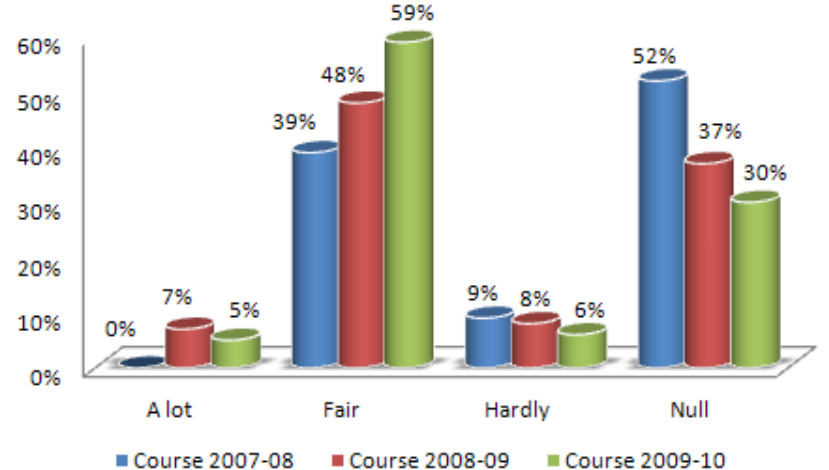
Fig. 1. Students’ opinion about the degree of satisfaction with the coordination of